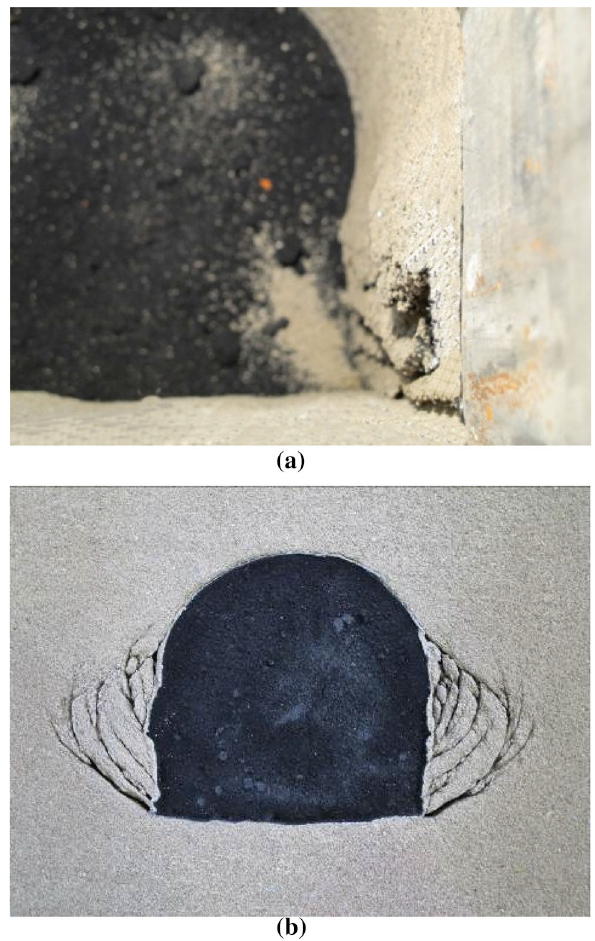
Fig. 6 Fracture form for the M3 model tunnel showing a the pressure stabilization process and b the macroscopic fracture form